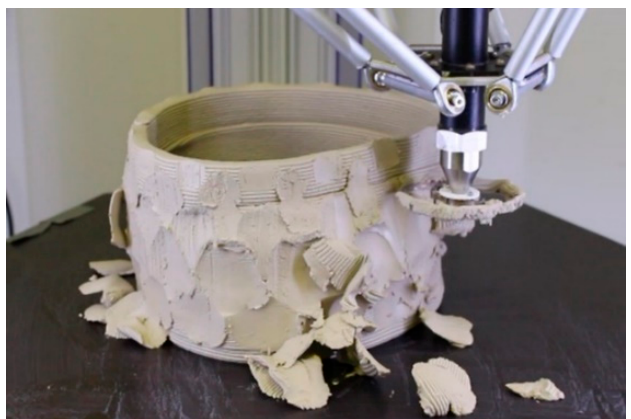
Figure 6. Generation of a cylinder (Table 6) as complex path instruction (material extrusion + tool) and cutting tool.